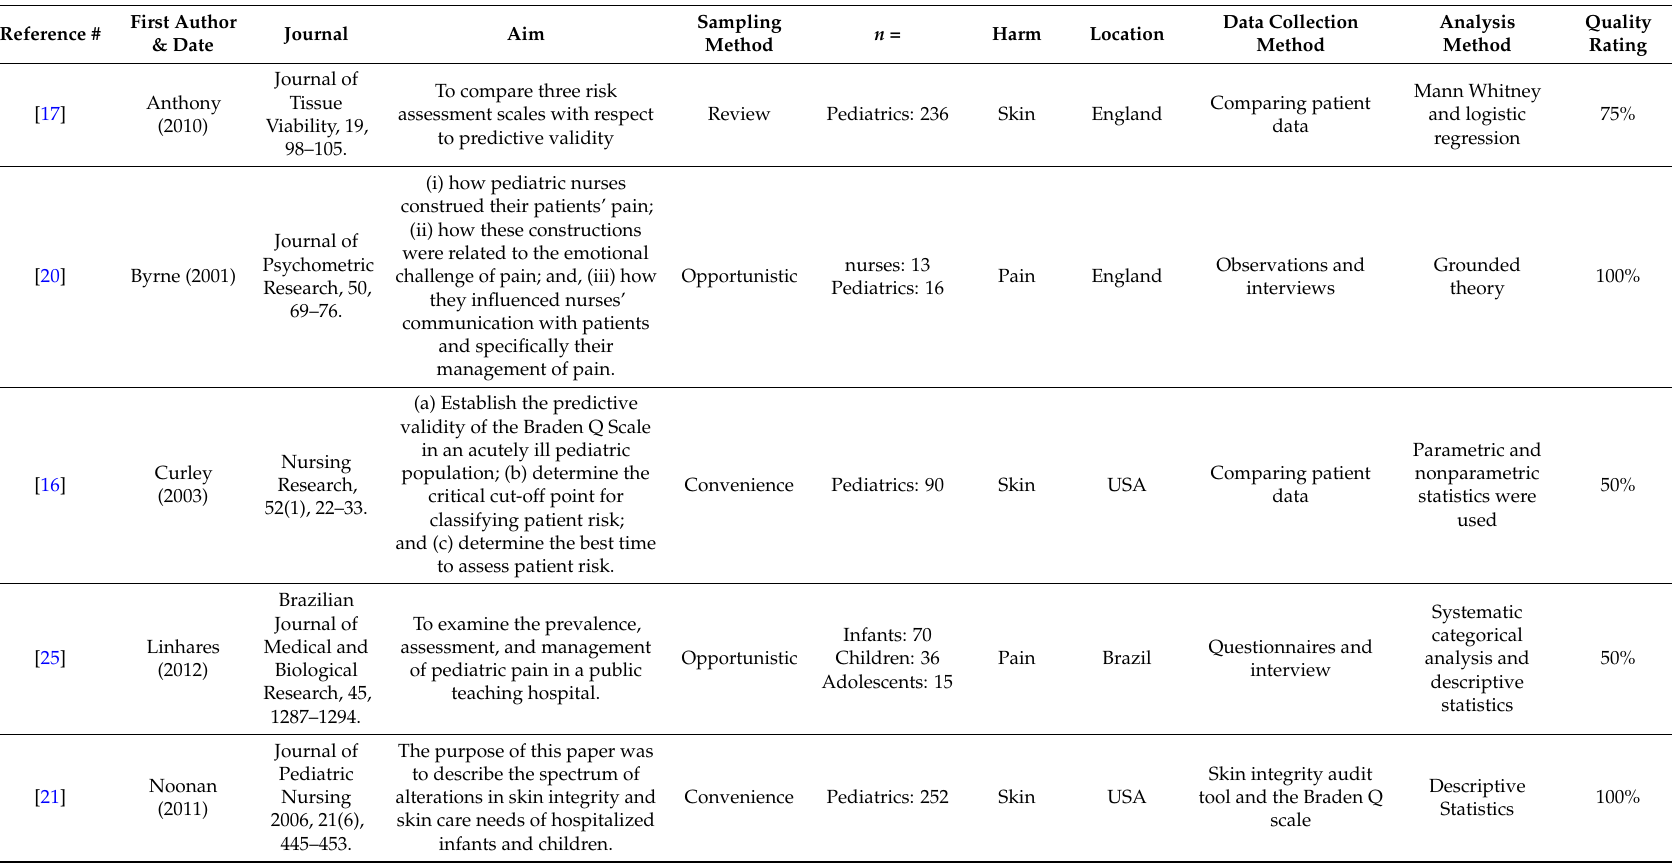
Table 2. Characteristics of included